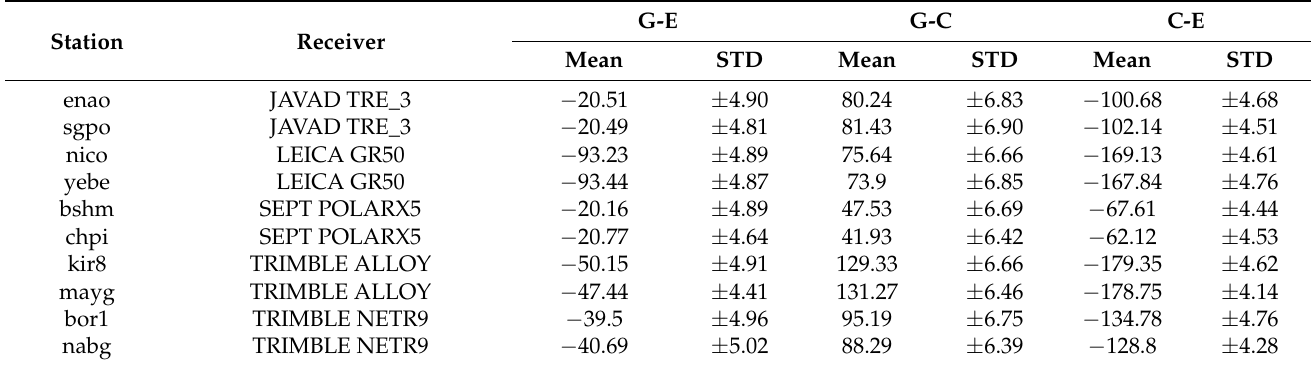
Table 6. Median and STD of the 28-day dual-frequency ISB for the 10 tracking stations (1 February 2022–28 February 2022).